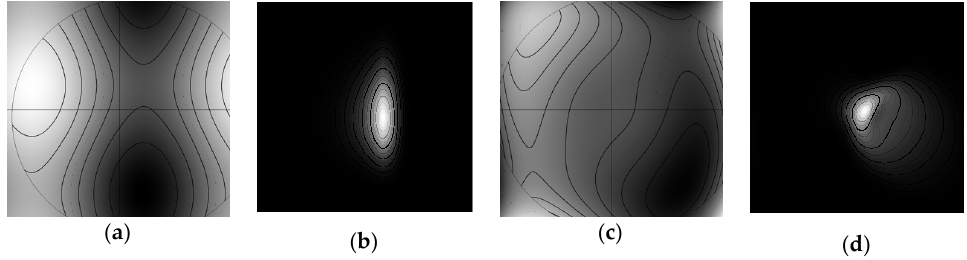
Figure 15. Increase in turbulence intensity ( r 0 = 0.1). Other parameters of numeric experiment are the same as in Figure 14. Phase distribution specified by the screen simulating atmospheric turbulence ( a ), amplitude distribution of a beam with initial phase profile specified by this screen ( b ), surface obtained as a result of approximation ( c ), amplitude of a beam ( d ) with initial phase presented in Figure ( c ). Table 7. Characteristics of the beam in the plane of observations calculated with increased turbu- lence intensity. Parameters of numeric experiment were the same as in the previous example (Fig- ure 15).